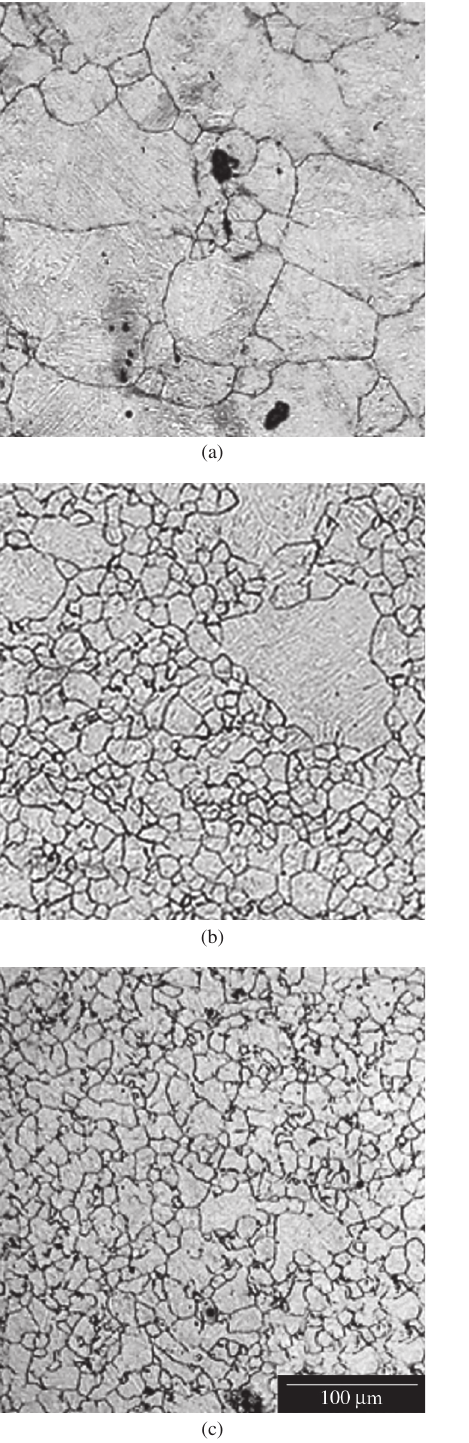
Figure 6. a) Summary of tensile and compressive true stress-strain curves; and b) deep rolling optimization curves for three automotive forging steels – imposed fatigue amplitudes are indicated in the figure legend 21